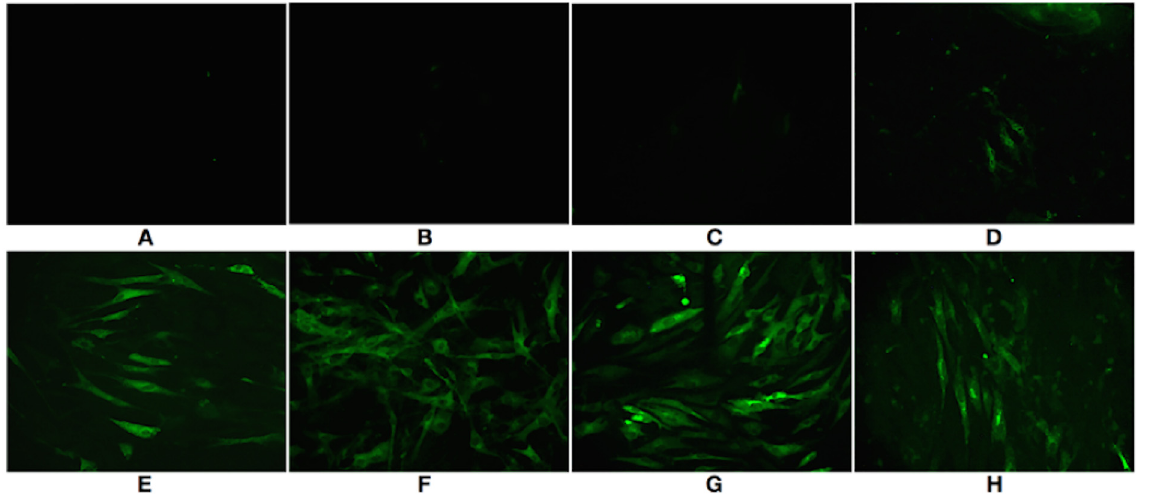
Fig 1. REV infection in chicken embryo fibroblasts. Detection of REV group antigen in infected monolayer of CEFs was visualised by IFA on day 1 (A), day 2 (B), day 3 (C), day 4 (D), day 5 (E), day 6 (F), day 7 (G) and day 10 (H) using fluorescence microscopy at an original magnification of 400×.